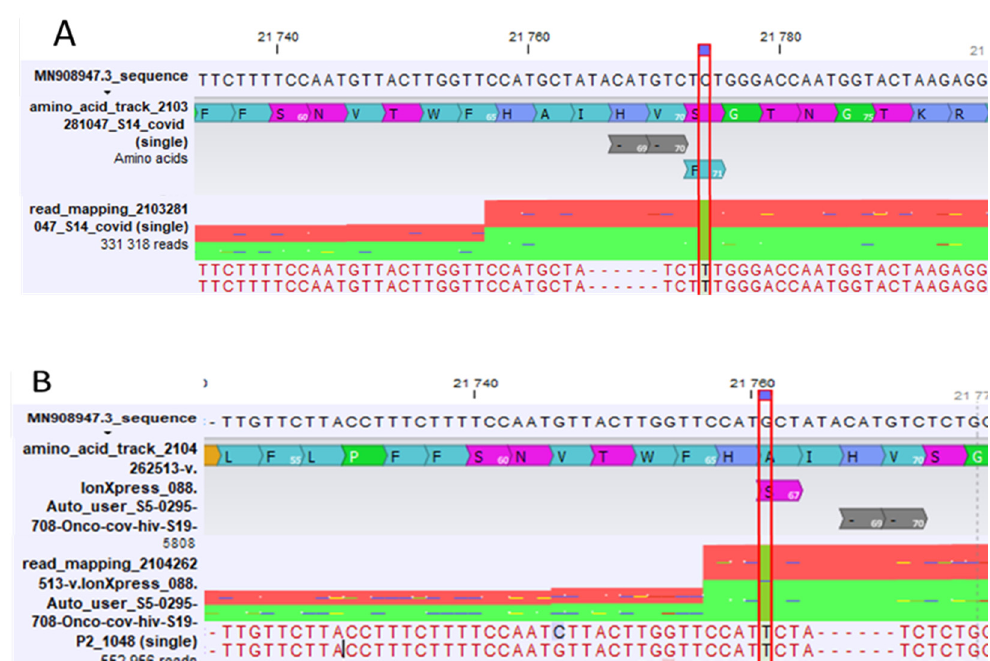
Figure 2. CLC genomics view of two mutations near the deletion Δ H69/ Δ V70. ( A ) mutation view of S71F; ( B ) mutation view of A67S.